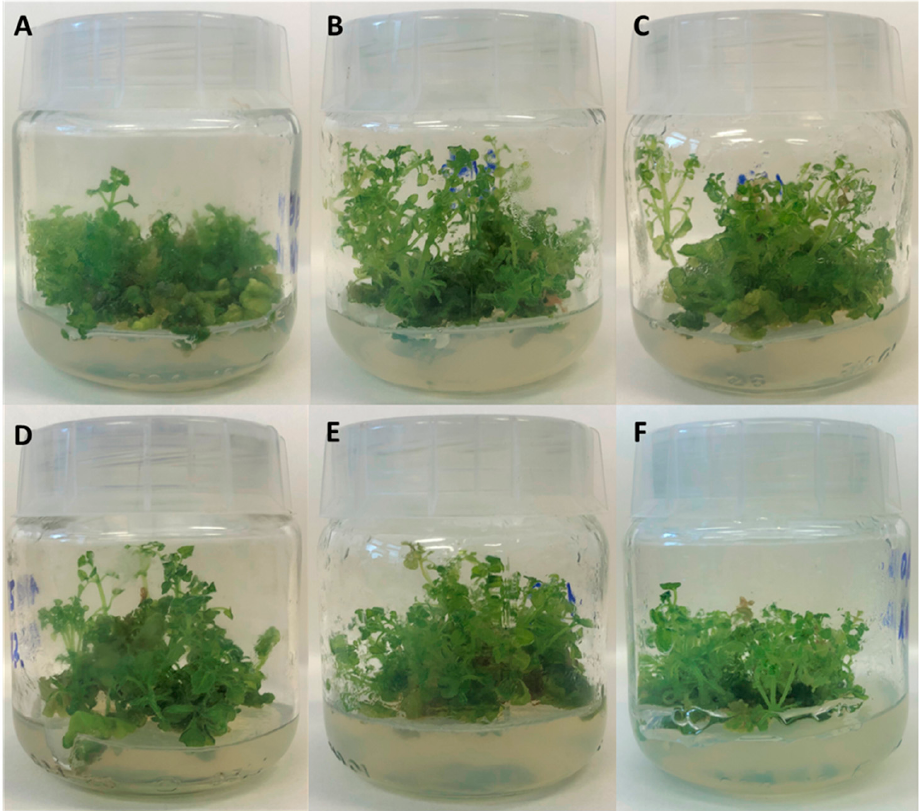
Figure 1. The appearance of Scutellaria brevibracteata subsp. subvelutina biomasses cultured in vitro depending on the concentration of PGR tested (BAP and NAA) (mg/L) in the MS medium variant (4-week growth cycle). Variant ( A )—3.0 mg/L BAP and 1.0 mg/L NAA; Variant ( B )—2.0 mg/L BAP and 2.0 mg/L NAA; Variant ( C )—1.0 mg/L BAP and 1.0 mg/L NAA; Variant ( D )—1.0 mg/L BAP and 0.5 mg/L NAA; Variant ( E )—1.0 mg/L BAP; Variant ( F )—0.5 mg/L BAP and 2.0 mg/L NAA.